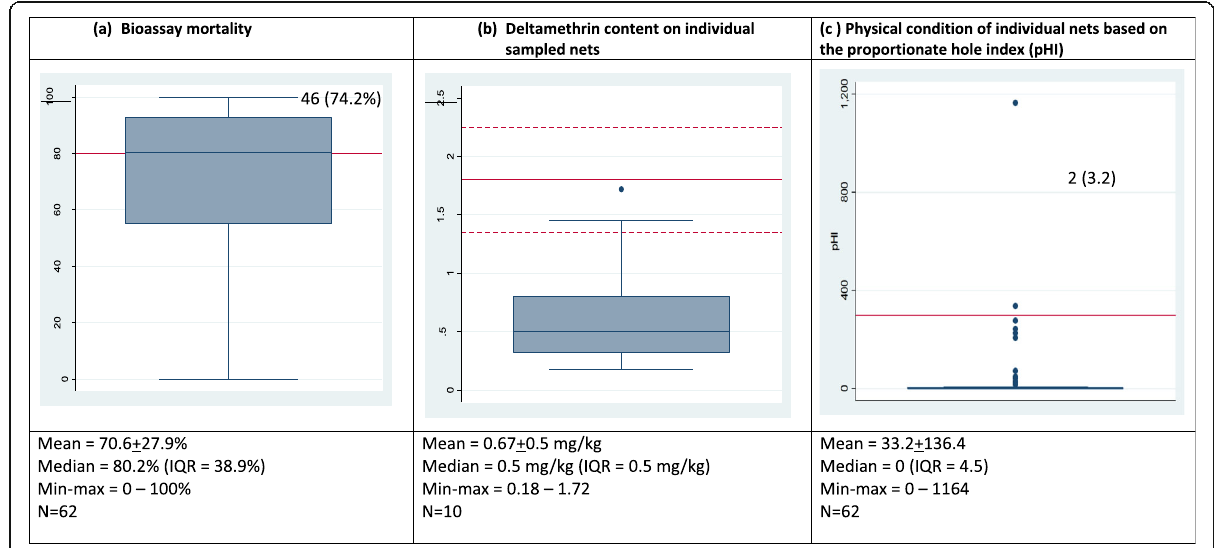
Fig. 4 Boxplot of PermaNet 2.0 2.0 showing a median mortality, inter-quartile range (0.25 – 0.75), and max-min range. Full red line is the 80%